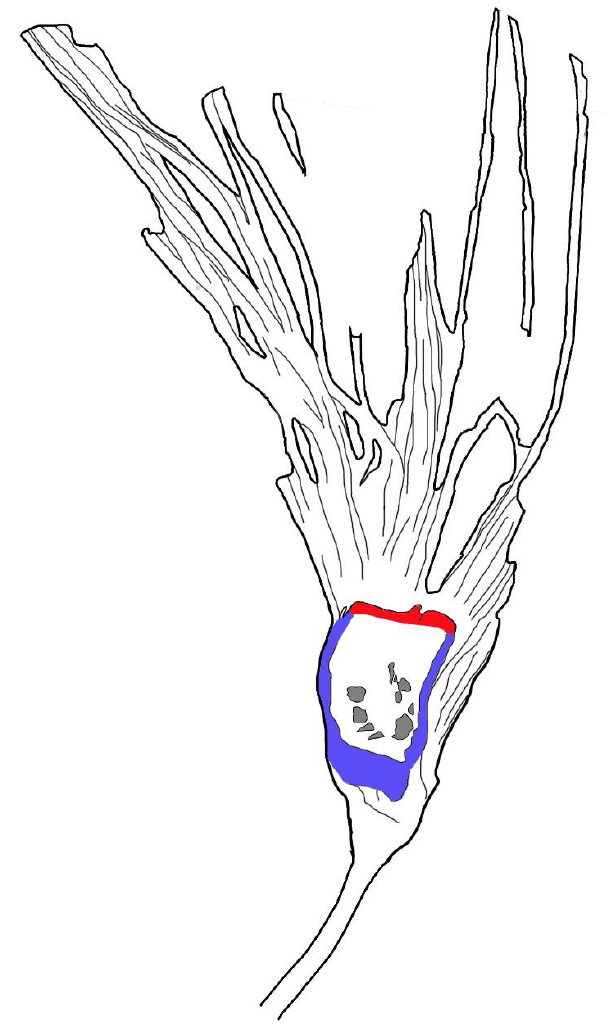
Figure 5. Sketch of Lingyuananthus inexpectus gen. et sp. nov. Note the ovule cavities (gray) in the ovary, ovary wall (=hypanthium) (blue), and floral roof (red) secluding the ovary.